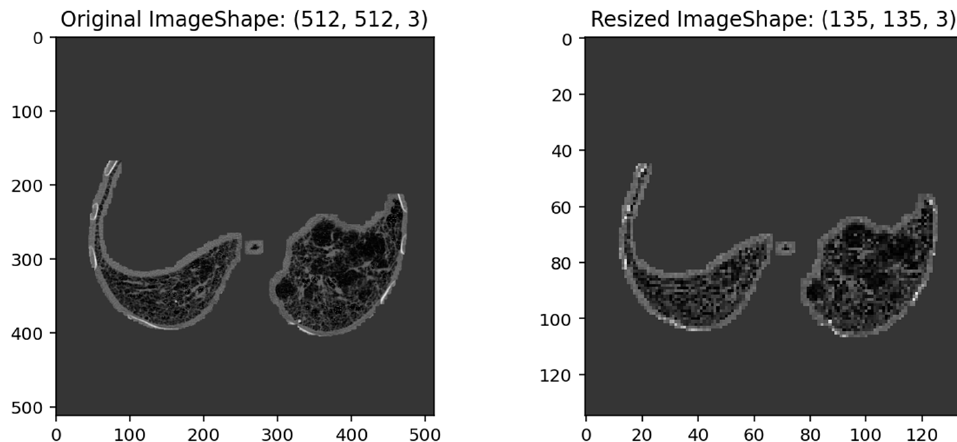
Figure 6. Illustrates the pixel size of an original chest CT image (512, 512, 3) and its corresponding resized input image (135, 135, 3) for the six-transfer learning